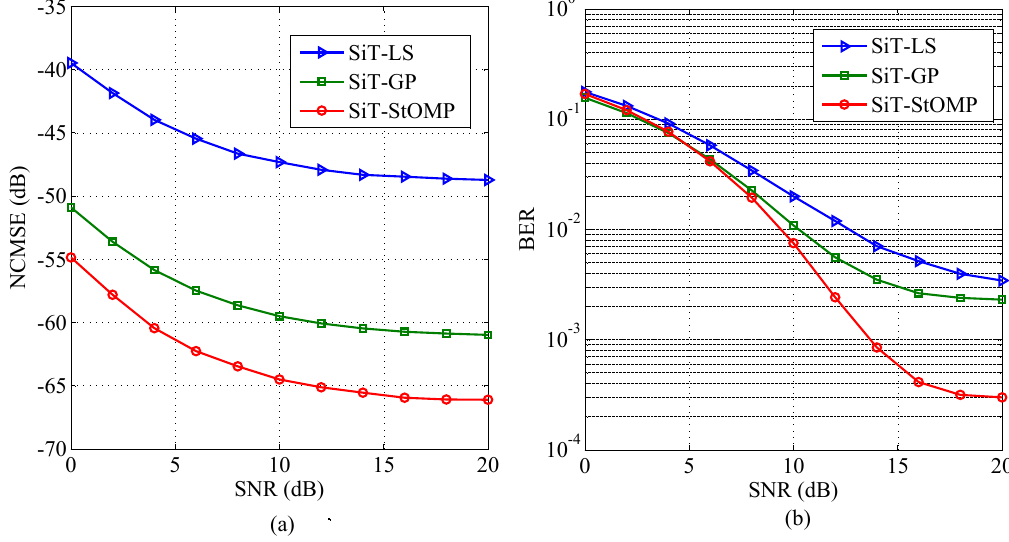
Figure 2. Normalized channel mean square error (NCMSE) and bit error rate (BER) based comparison of proposed SiT-StOMP and SiT-GP techniques with SiT-LS for massive-MIMO uplink communications, = 0.2, ( a ) MSE based performance comparison; ( b ) BER M = 1500 bits, Q / L = 3/14, and σ 2 c / σ 2 b nt nt based performance